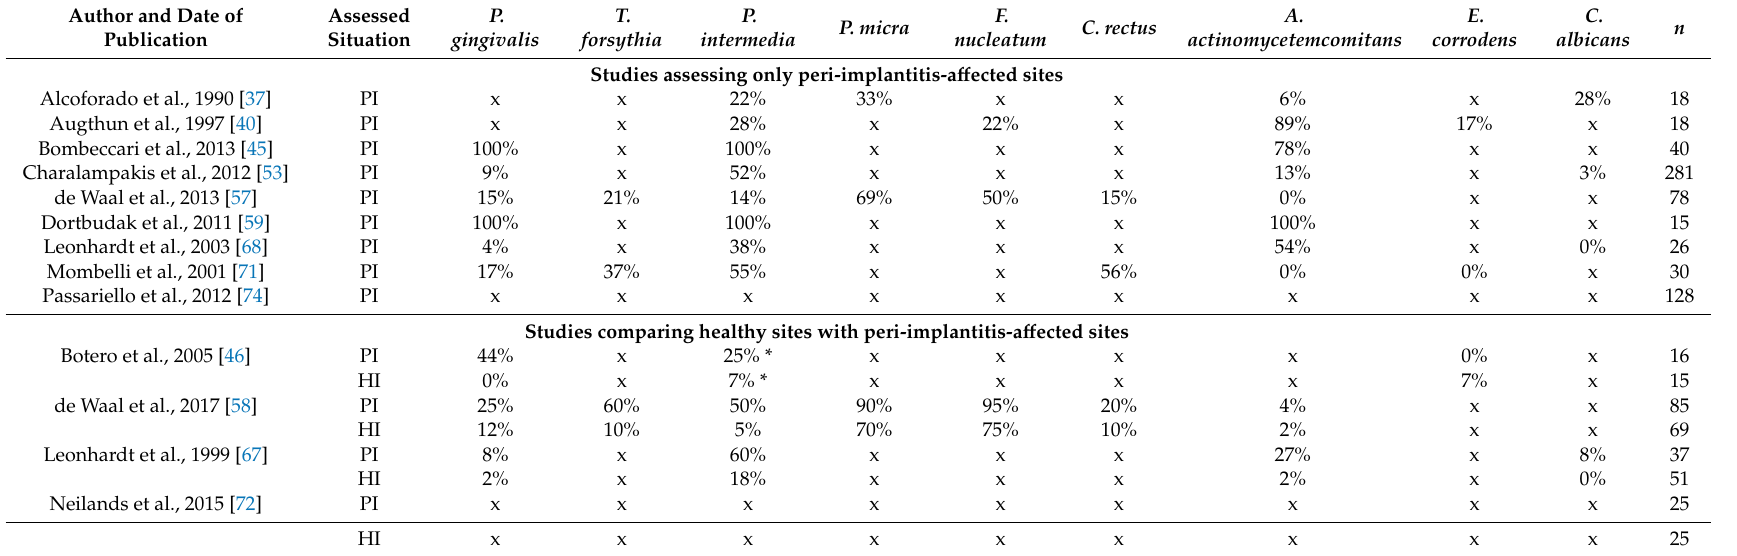
Table 2. Studies assessing di ff erent species using culture-based